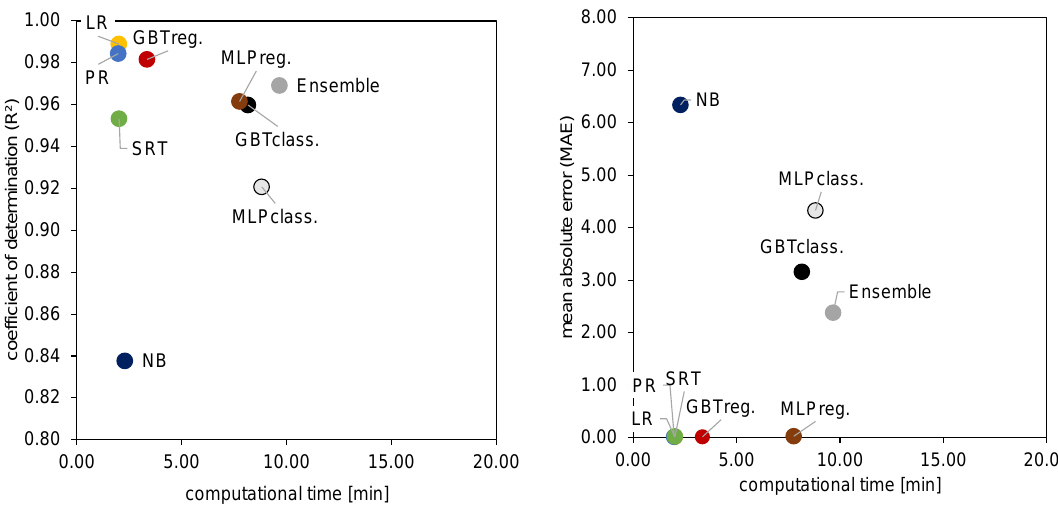
Figure 17. Evaluation of data mining results predicting the electric power.